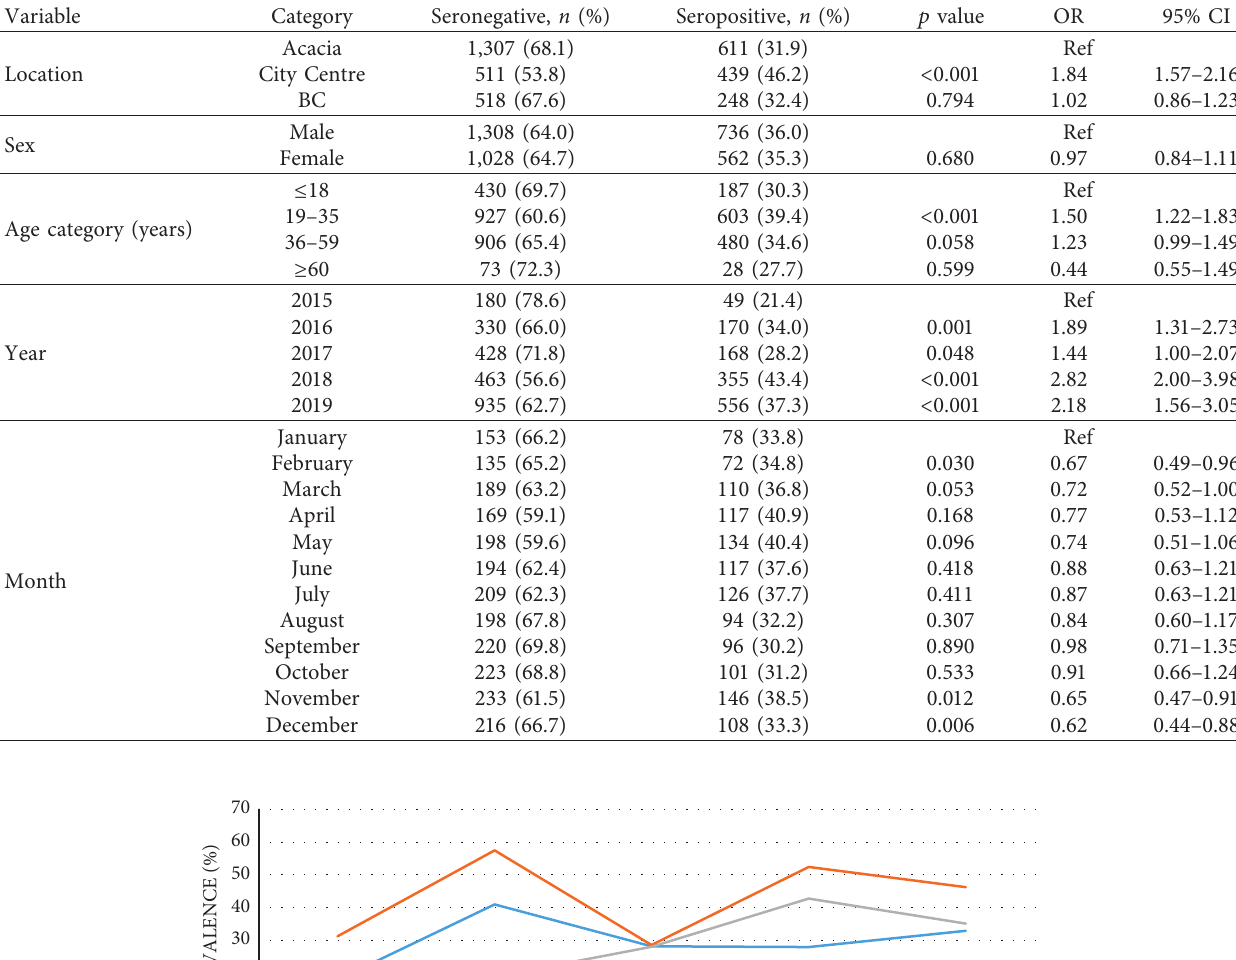
Table 1: Bivariate analysis of H . pylori infection versus demographics, years, and months.